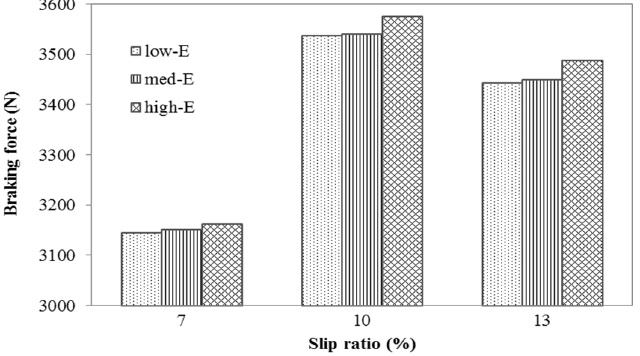
Figure 10. Braking force of pavement under different slip ratios.